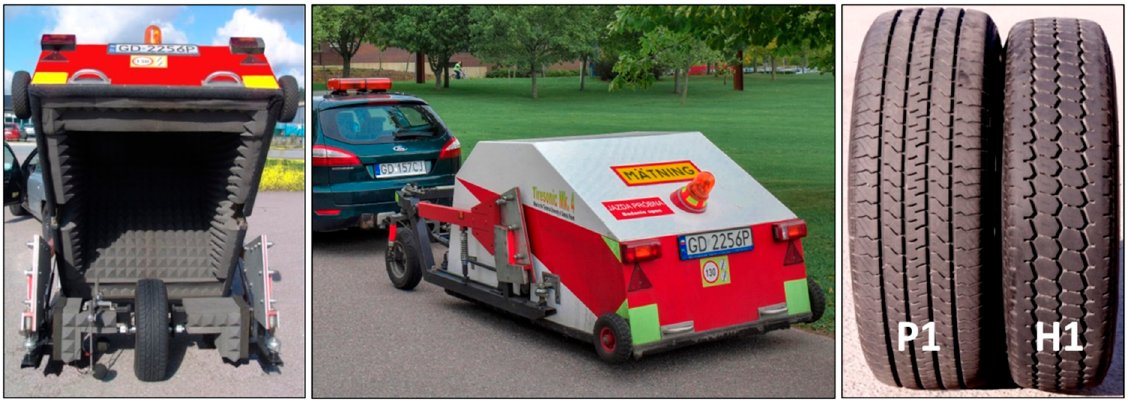
Figure 21. CPX test trailer Tiresonic Mk4 and the two ISO reference test tyres used: P1 and H1.